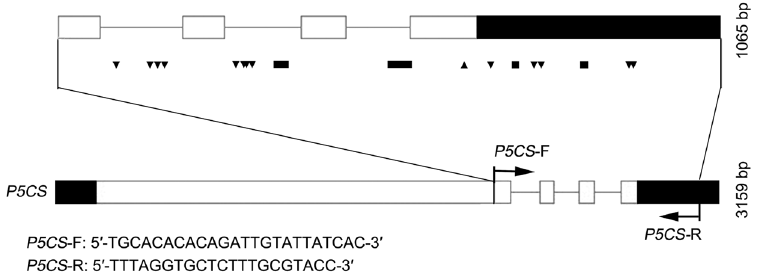
Figure 1. Diagram of PCR amplification and distribution of SNPs in HvP5CS1 . White boxes are the coding sequence of exons, black boxes are the 5 ′ -UTR and 3 ′ -UTR, and black lines are introns. The relative positions of the PCR products amplified for EcoTILLING are indicated as arrows and black bars. Black up arrows indicate changes in coding regions of DNA and do not affect the amino acid sequence of the protein product. Black down arrows indicate changes in the non-coding regions of DNA. Black bars refer to either insertions or deletions.